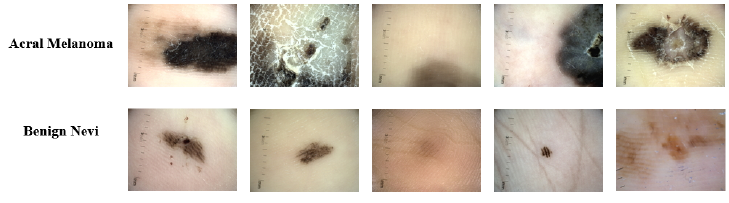
Figure 8. Acral melanoma and benign nevi sample